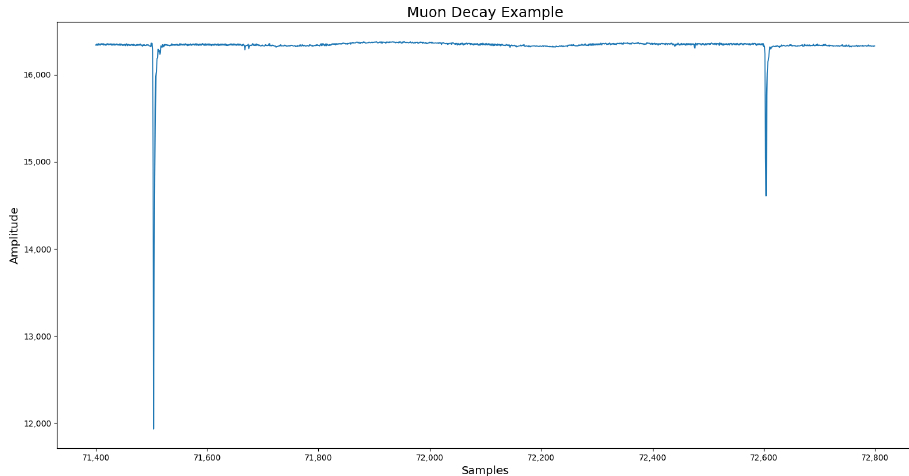
Figure 4. Example of muon–electron